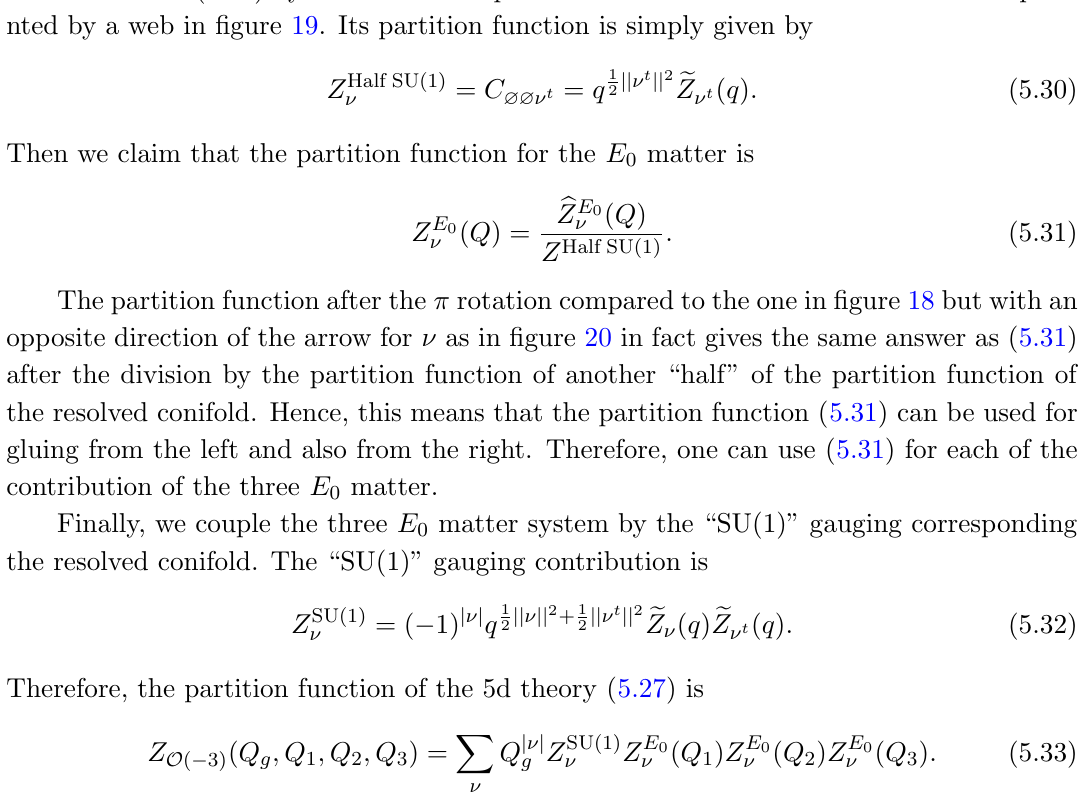
Figure 20 . Another web diagram for the E 0 matter with an opposite direction for the arrow associated to (cid:23) compared to the one in (cid:12)gure